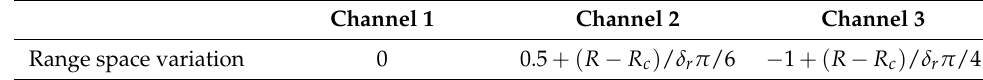
Table 5. Linear phase error setting of range.